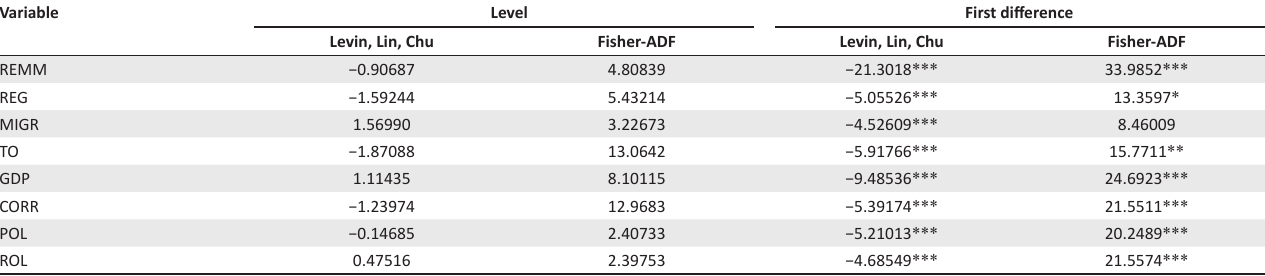
TABLE 4a : Unit root and cointegration tests. Variable